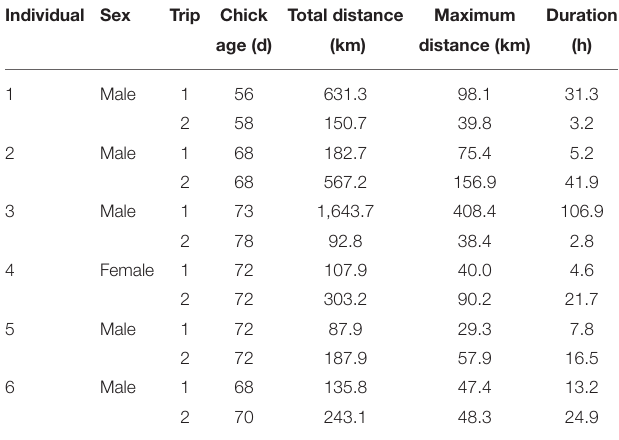
TABLE 5 | Foraging trip parameters of six adult Cape gannets tracked over two consecutive foraging trips during the post-guard stage of the 2015/16 breeding